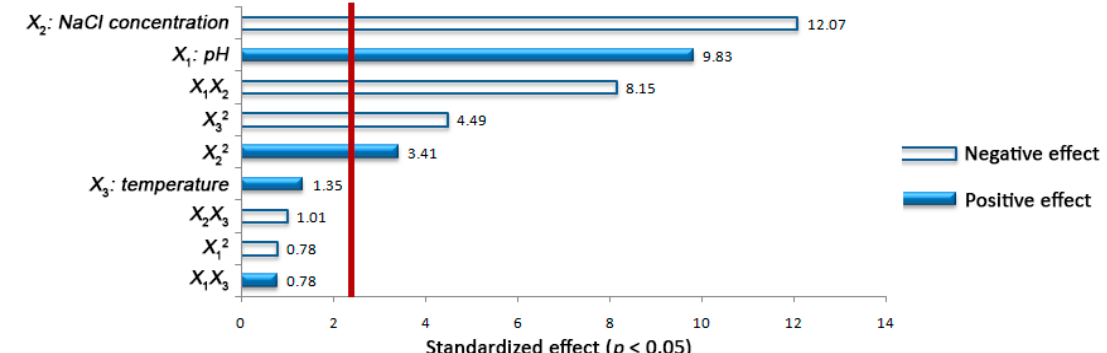
Figure 2. Standardized ( p < 0.05) Pareto chart in the central composite design for the effects of pH value ( X 1 ), NaCl content ( X 2 ), and temperature ( X 3 ) as well as of their interactions on the growth of the Enterococcus casseliflavus isolate ( Y ) in MRS broth. The bars crossing the reference line (red bar) correspond to statistically significant effects ( p < 0.05).